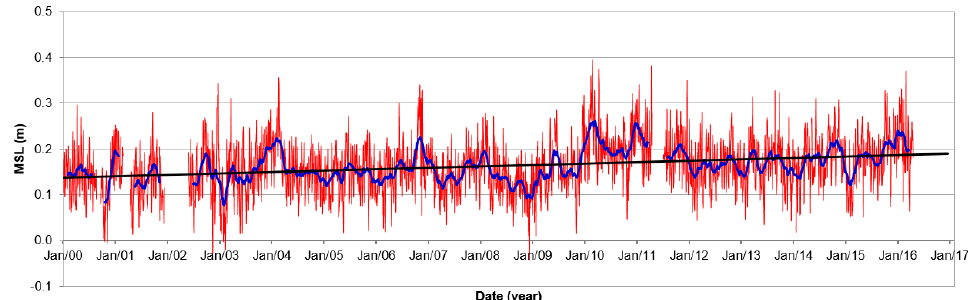
Figure 5. Daily mean sea level series (in meters) at Cascais TG, from 2000 to 2016, relative to the national vertical datum (in red), corrected from inverse barometric effect, vertical displacement, and mean seasonal oscillation, with a 6-months base period moving average (in blue). Analog TG data from Jan/2000 to Nov/2003 and from new acoustic TG data from Nov/2003 to